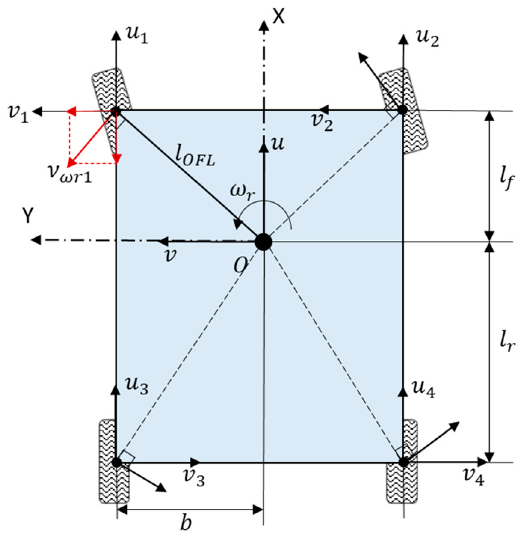
Figure 1. Vehicle model used for velocity estimation.